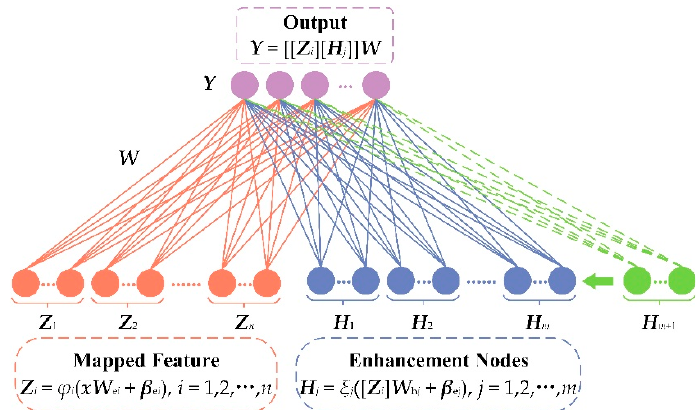
Figure 5. The basic structure of broad learning system.